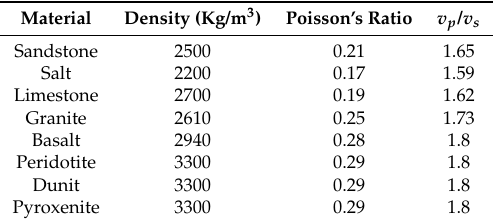
Table 1. Principal materials or geologic formation properties taken from [27].